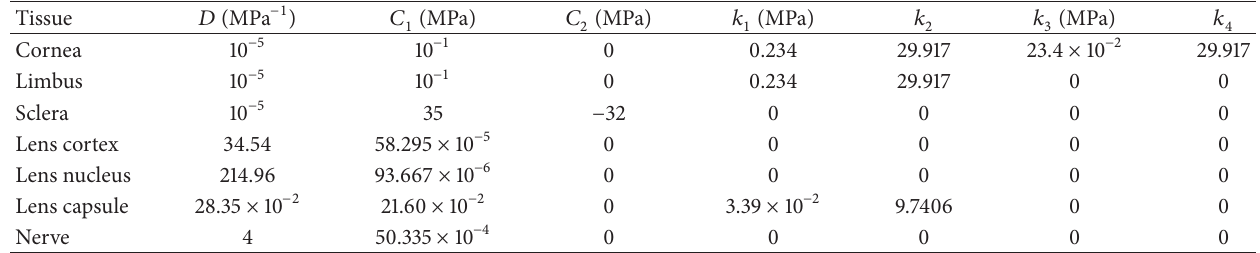
Table 1: Material parameters of the tissues in the anisotropic fibred model of the eye. 𝐷 is a penalty coefficient for computational purposes; 𝐶 𝐶 1 and 2 are the material parameters of the extracellular matrix. The parameters directions,